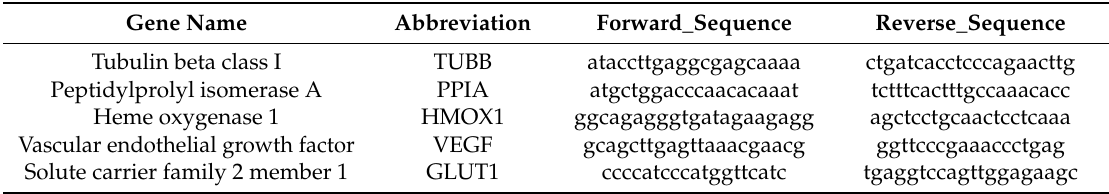
Table 4. Primer sequences for Quantitative real-time PCR (qRT-PCR)